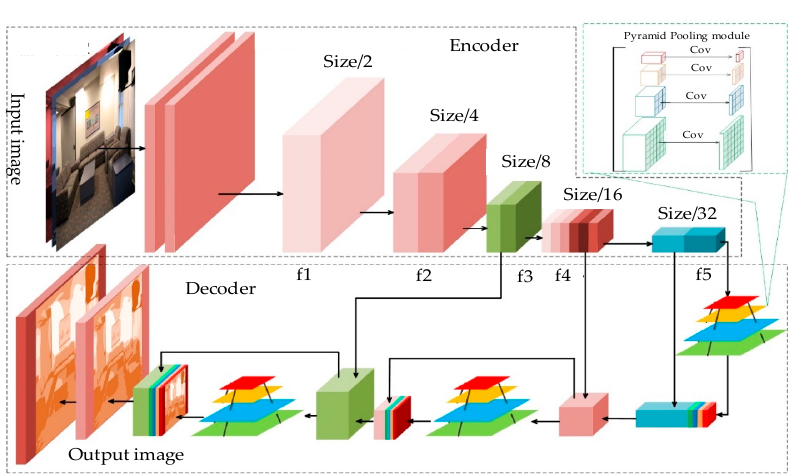
Figure 2. Improved PSP-Net network. Our improved PSP-Net network uses the encoder network MobileNetV3 to extract multi-level feature information. The structure is shown in Figure